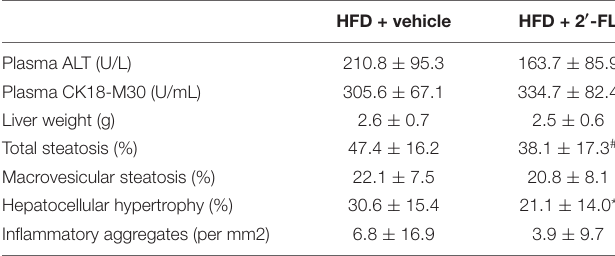
TABLE 2 | Liver integrity markers, liver weight and NAFLD score after 28